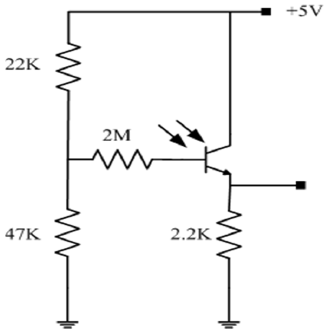
Figure 3. The photo detection circuits.